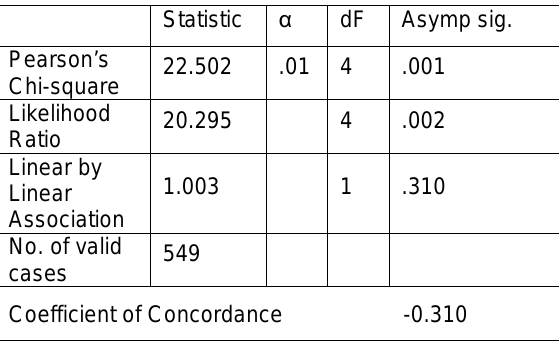
Table 9: Pearson’s Chisquare result and Kendall’s Coef fi cient of Concordance test for the operational state of building elements and